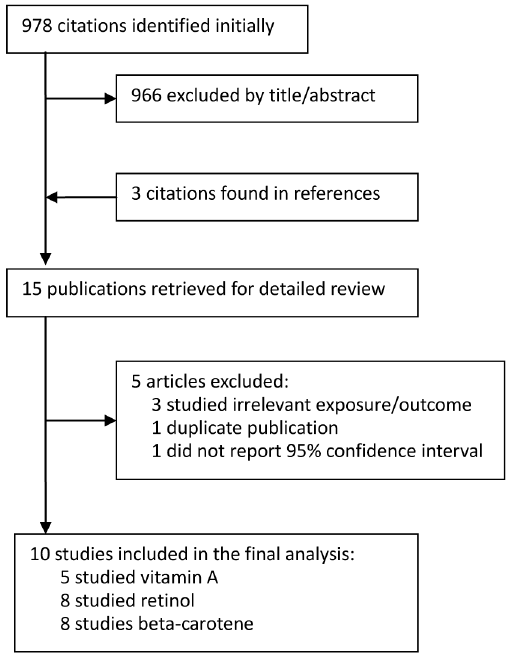
Figure 1. Flow diagram of systematic literature search.